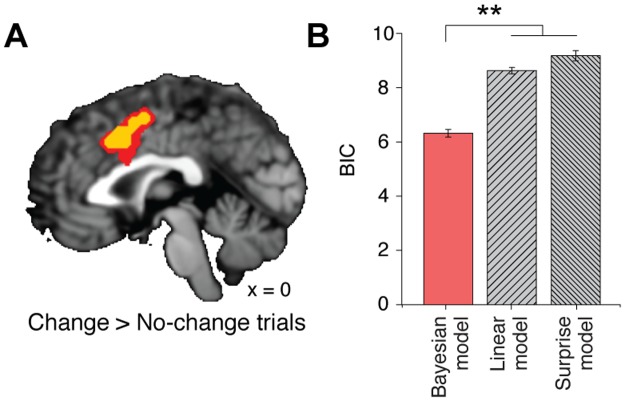
Dorsal anterior cingulate cortex (dACC) activity when changing judgments to conform to the group’s and comparison between the predictions of different models in this brain region.(A) The dACC was more engaged with conformity trials compared with nonconformity trials. (B) The Bayesian model explains dACC activity more accurately than those of alternative models (general linear model [GLM]3). The time courses accounting for the blood-oxygen-level dependent (BOLD) signal in association with the changes in judgments were extracted from the region of interest (ROI) in dACC. These time courses were compared with other time courses in association with the predictions of each model about changes in judgments. Error bars represent the standard error of the mean (SEM). All the parameters were estimated from the same ROI defined in the dACC (10-mm diameter spherical ROI at x, y, z = 8, 18, 46; **, P < 0.001). The functional MRI (fMRI) data can be found in http://neurovault.org/collections/2503/. The data underlying Fig 4B can be found in S1 Data.